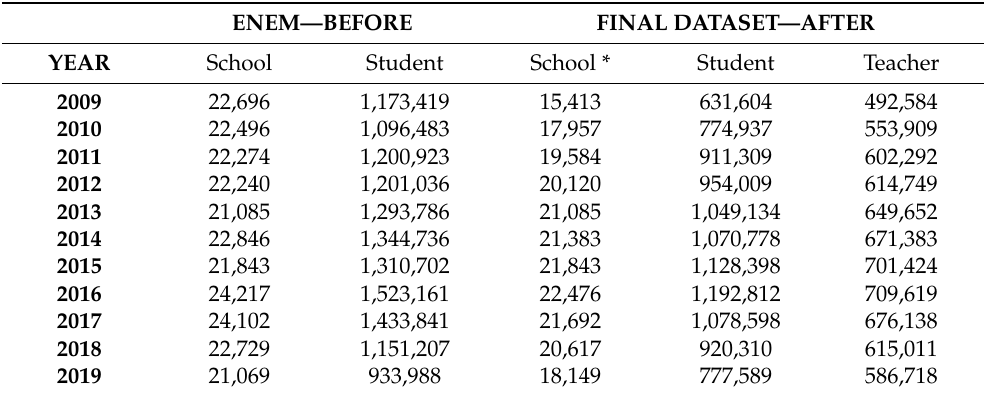
Table 1. Number of schools, students before and after scope definition and the number of teachers used to build teacher variables in the school level. ENEM—BEFORE FINAL DATASET—AFTER School Teacher